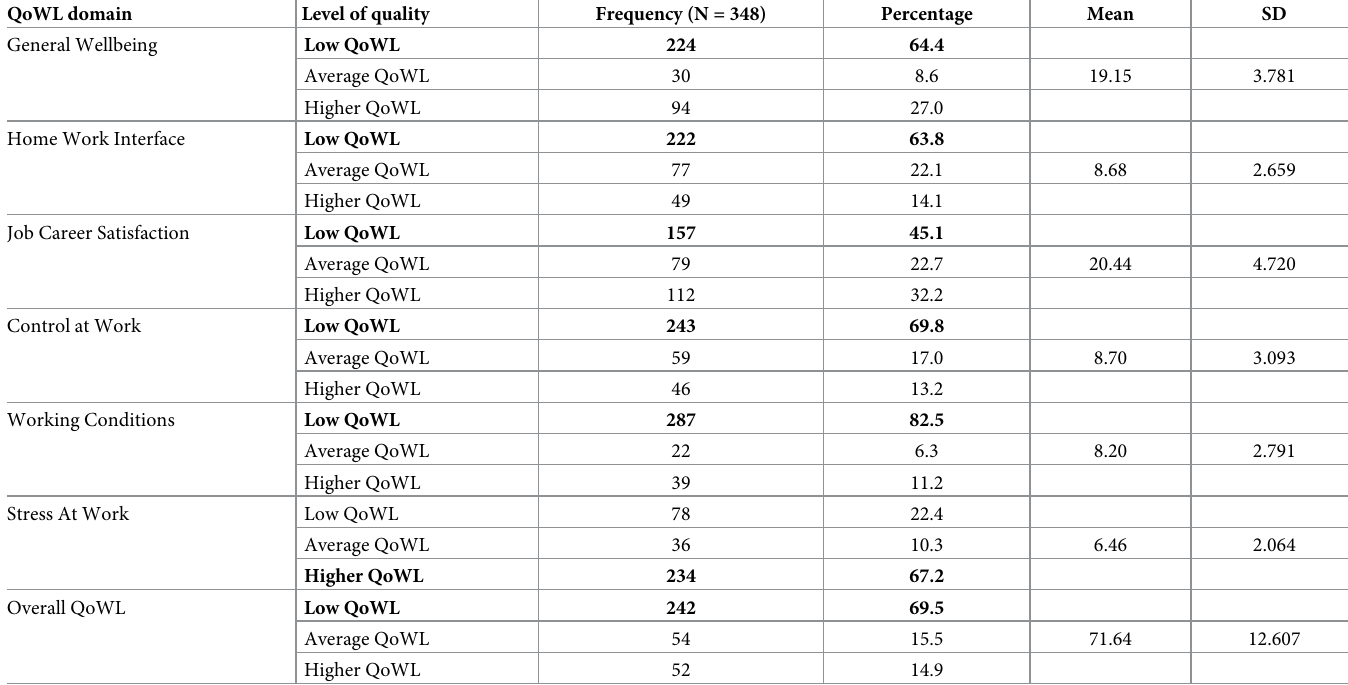
Table 2. Level of QoWL among RNs.